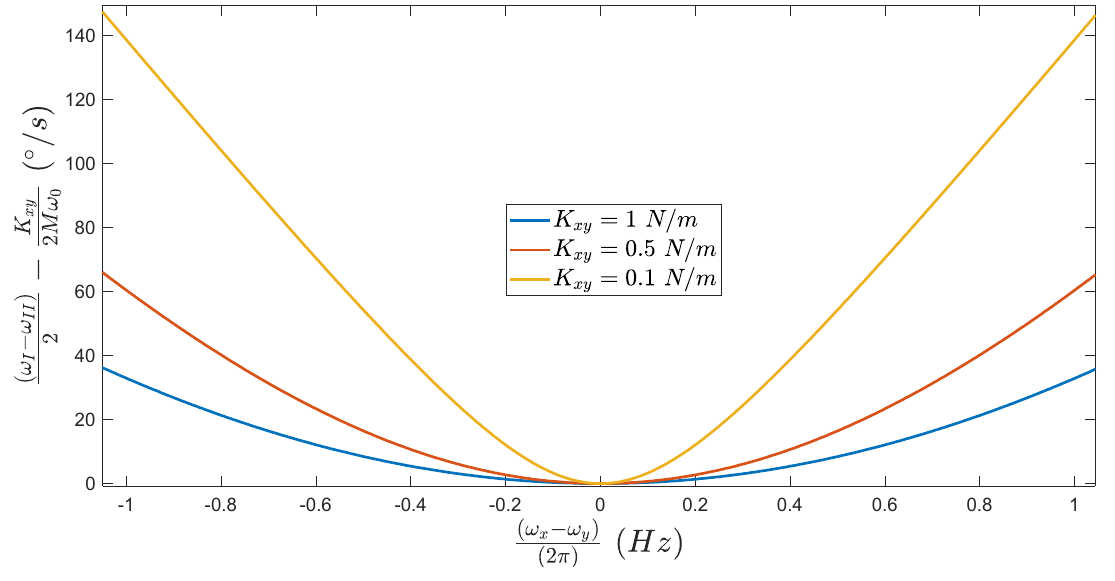
(cid:3104) (cid:3299) (cid:2879)(cid:3104) (cid:3300) (cid:16) ω (cid:17) (cid:4673) , x − ω y , (cid:2870)(cid:3095) 2 π